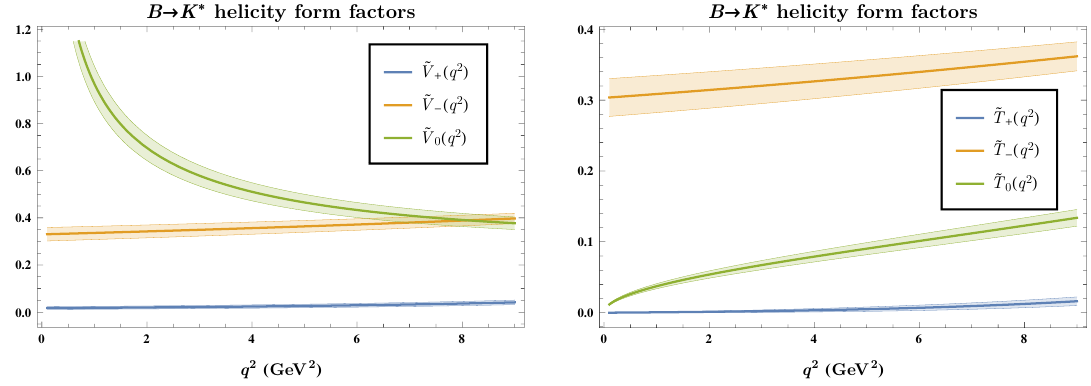
Figure 1 . The central values and uncertainties of the B ! K (cid:3) helicity form factors ~ V (cid:6) ; 0 and ~ T (cid:6) ; 0 using the LCSR results [27] for the traditional form factors V; A 1 ; 12 and T 1 ; 2 ; 23 . QCDf and into the non-factorisable power corrections denoted here as h